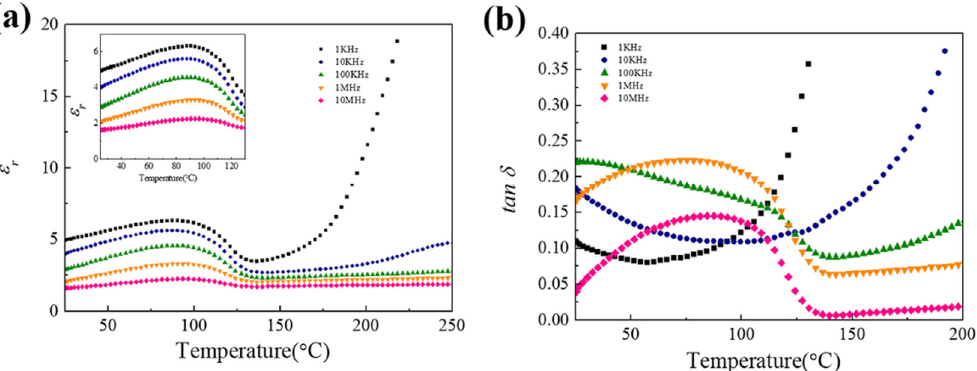
Figure 6. The dielectric constant ( a ) and dielectric loss ( b ) of IEVMT film at different temperatures in the frequency range of 1 kHz to10 MHz.